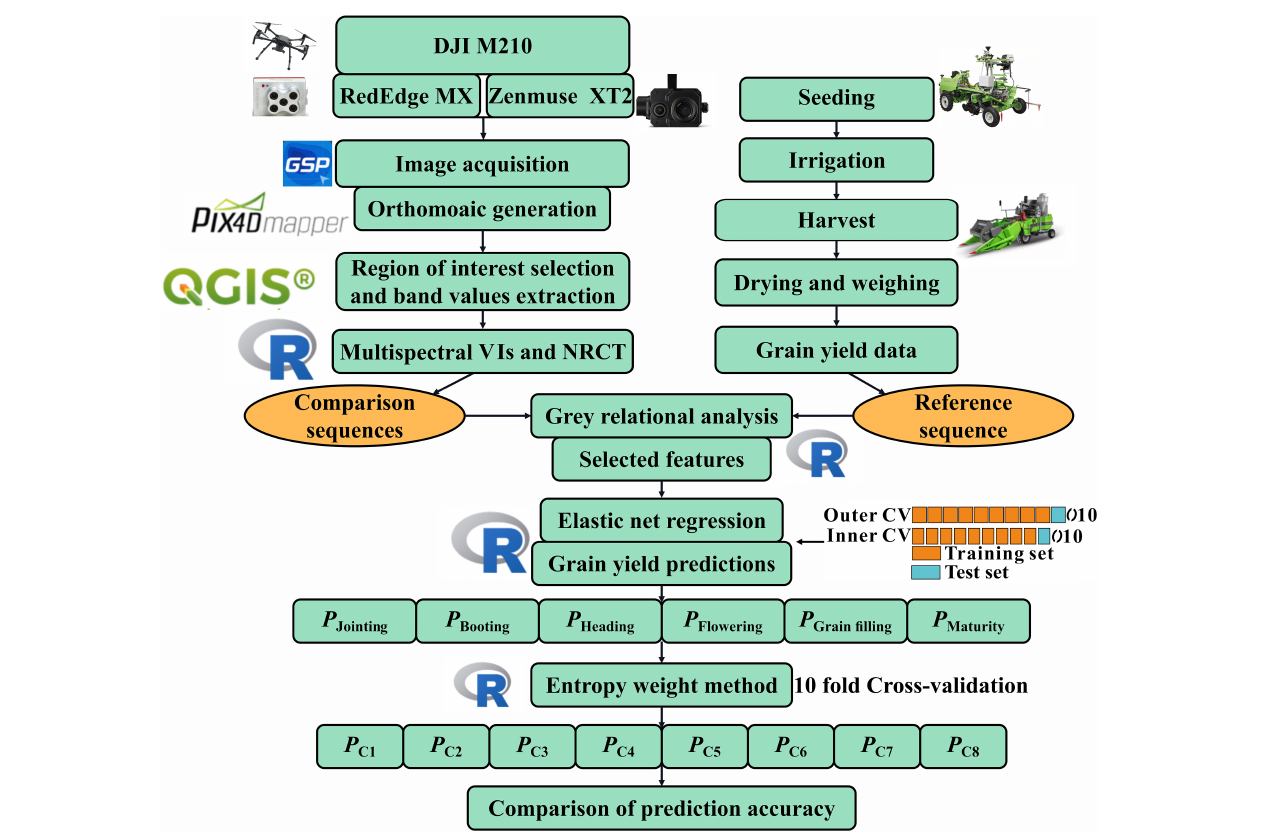
FIGURE 2 | Schematic workflow of the methodology used in this study. P denotes the predicted grain yield (GY) value, and C1–C8 indicate the combinations of the values predicted from multiple growth stages. CV, cross-validation; VIs, vegetation indices; NRCT, normalized relative canopy temperature.